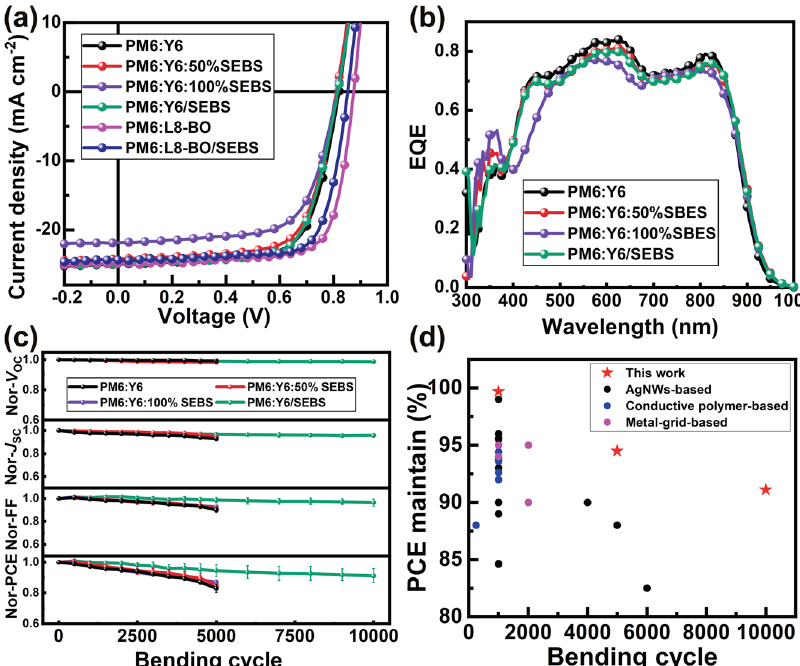
Fig. 4 Device performance. a J – V characteristics and b EQE spectra of SEBS treated devices. c Evolution of VOC, JSC, FF, and PCE after 5000 outward bending cycles with a radius of 5 mm for the PM6:Y6, PM6:Y6:50% SEBS, PM6:Y6:100%SEBS, and PM6:Y6/SEBS fi lms-based fl exible devices. d Summary of bending durability of the